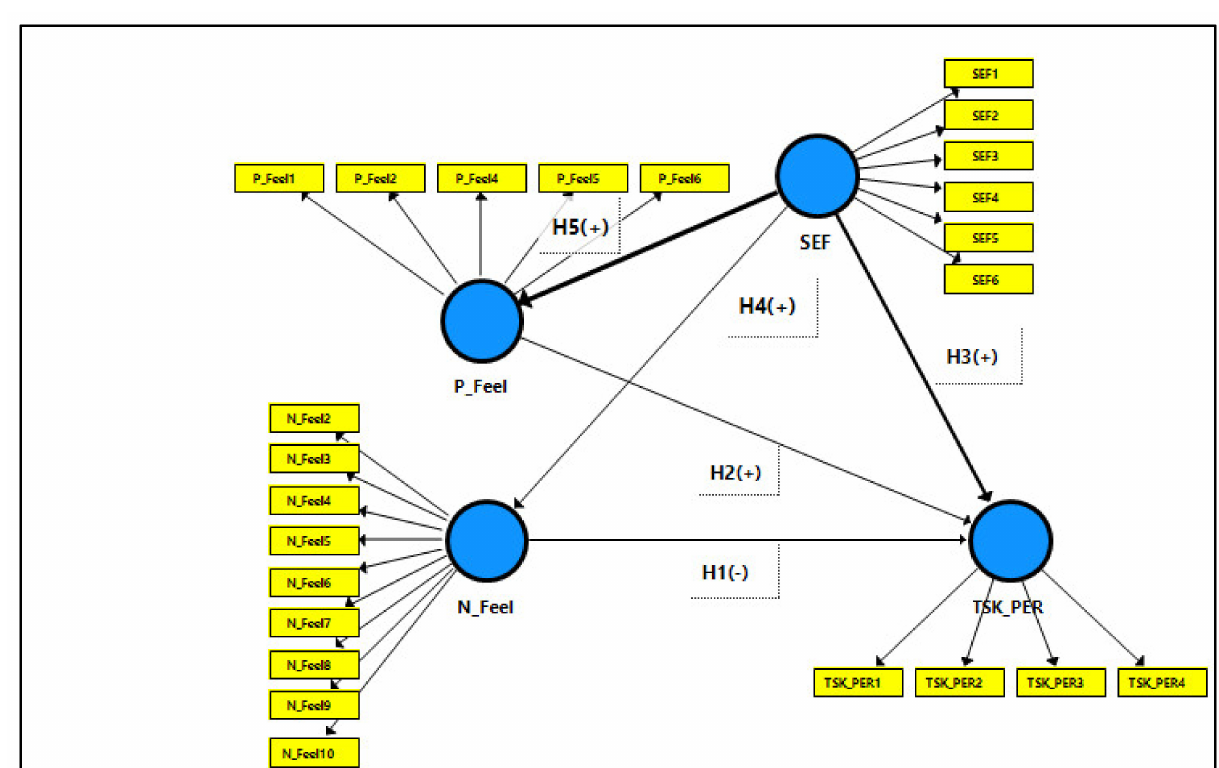
Figure 1. The research’s conceptual